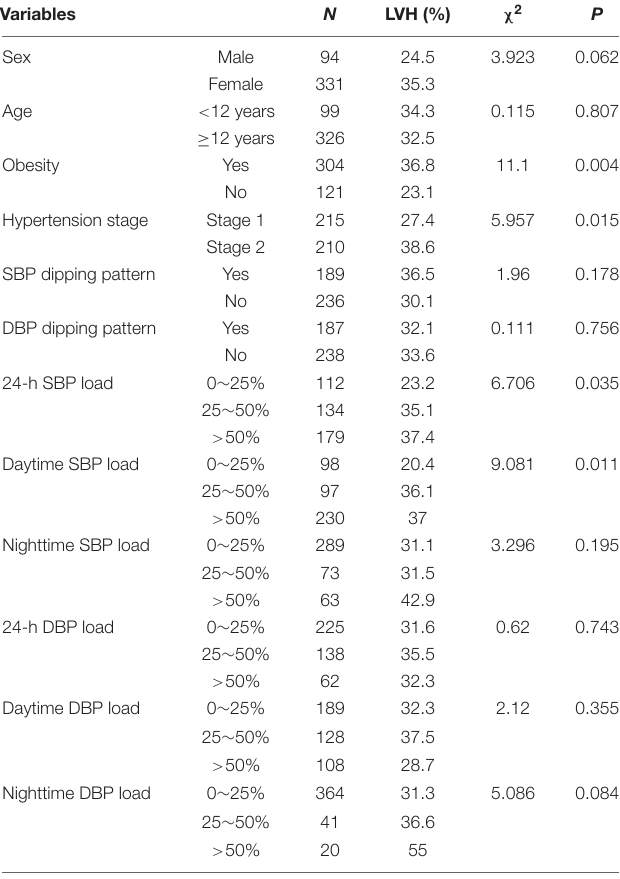
TABLE 5 | The univariate analysis of left ventricular hypertrophy.